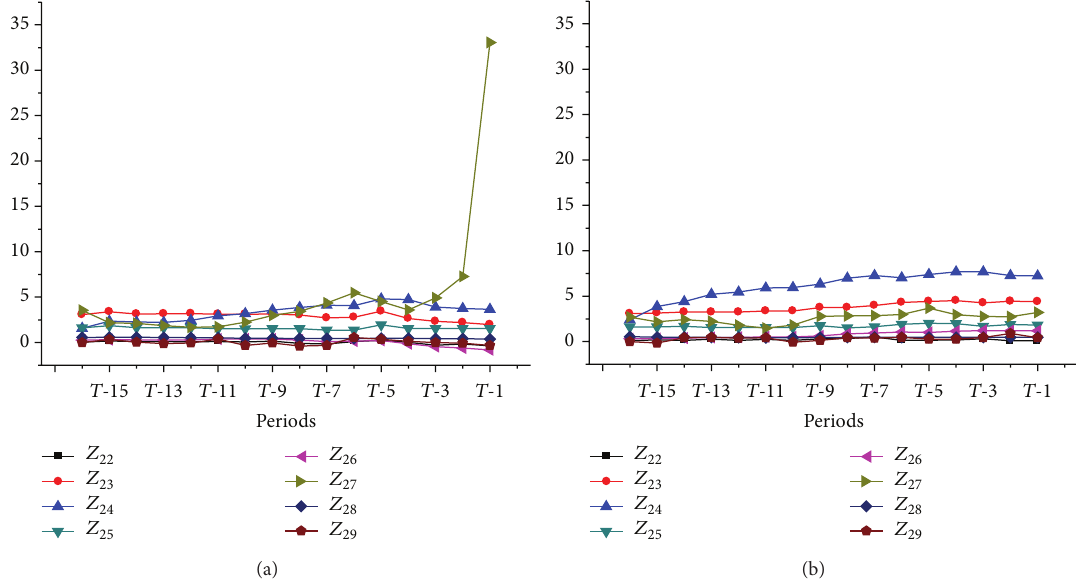
Figure 6: The trend analysis of mean of signal indicators of market reaction for distress samples and healthy